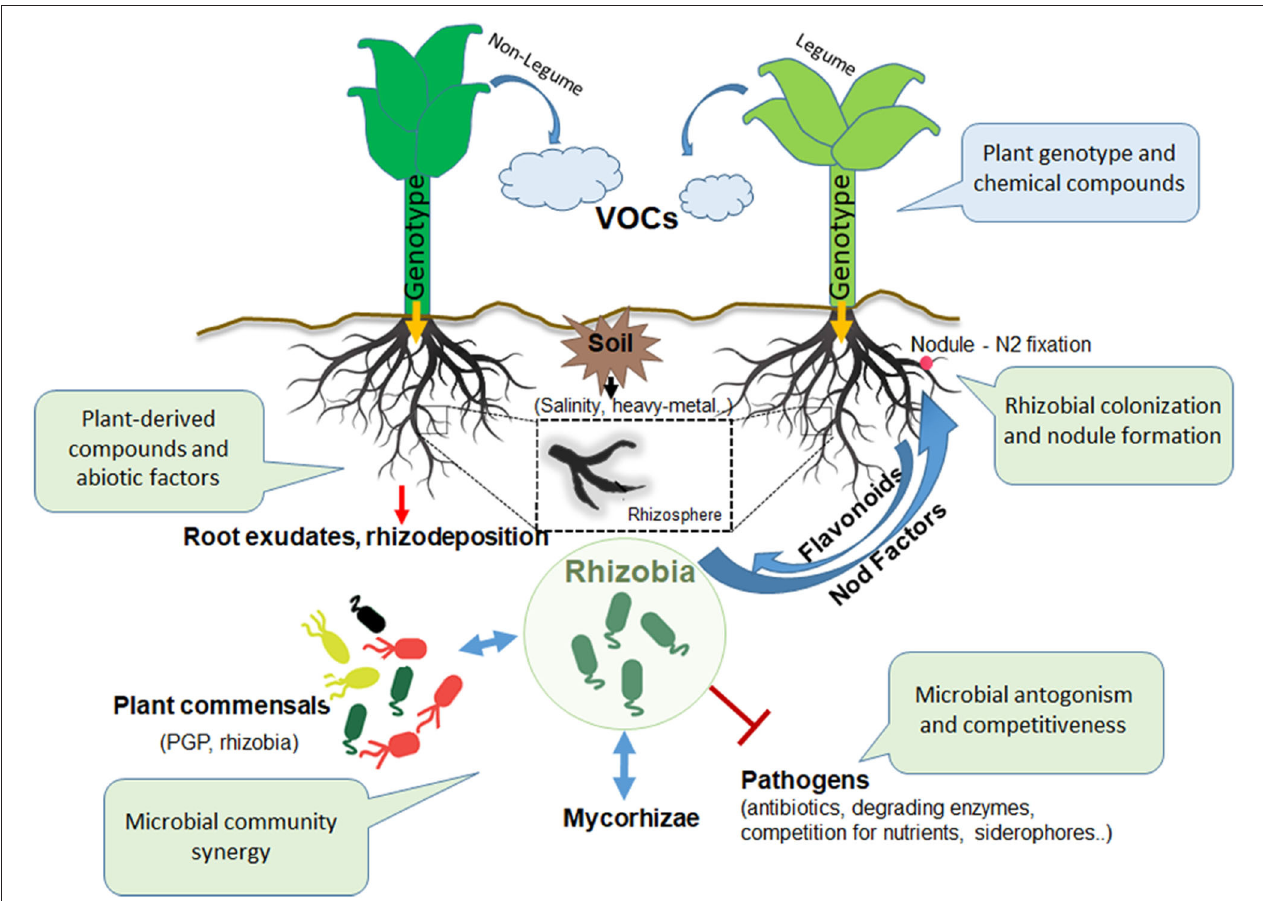
FIGURE 1 | Actors and interactions in the rhizosphere. Inter-kingdom and intra-kingdom communication involving plants and microbes in the rhizosphere: the consistent role of rhizobia. VOCs, volatile organic compounds; PGP, plant growth promoting; AMF, arbuscular mycorrhizal